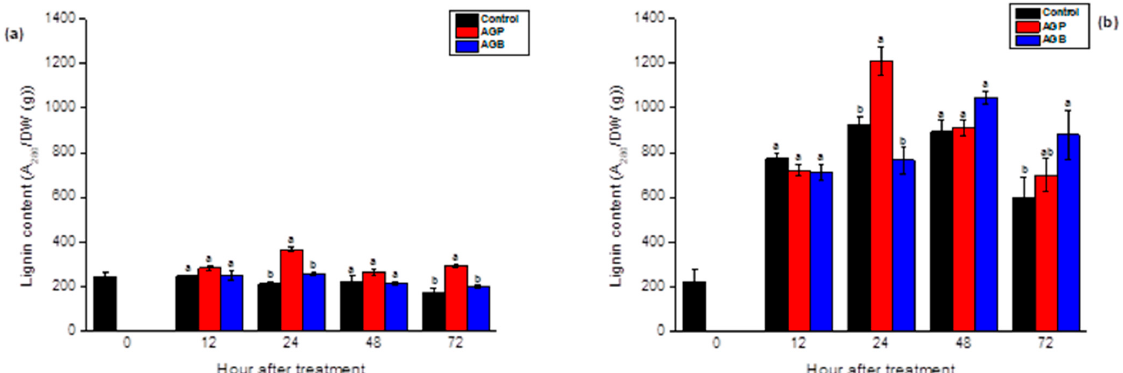
Figure 8. Lignin content in the leaves ( a ) and the roots ( b ) of tomato seedlings after injection (10 µ L) of AGB and AGP fractions (1 g/L). Each value is the mean of four repetitions ± SE. The letters (a, b) indicate significant differences between treatments (Control, AGB, and AGP) in each point time using the Tukey-HSD test, at ( p < 0.05). Treatments presented with the same letter are not significantly different.